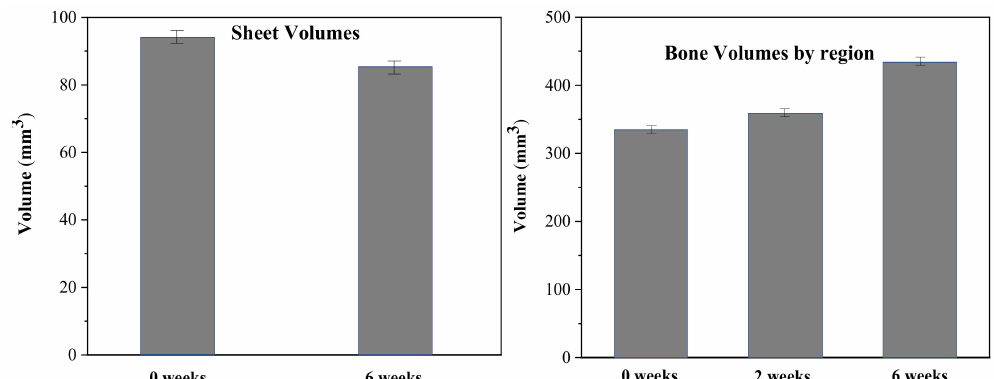
Figure 11. Mg-RE sheet degradation after 6 weeks was estimated by the volume of quantification. This shows a sheet volume loss of 9.32 ± 0.86 mm 3 after 6 weeks. MicroCT 3D rendering after 2 weeks shows there was no obvious change in bone growth around the degrading Mg-RE sheet. By 6 weeks, as new bone formed between the sheet and the bone, a notable change in bone volume was observed from 2 to 6